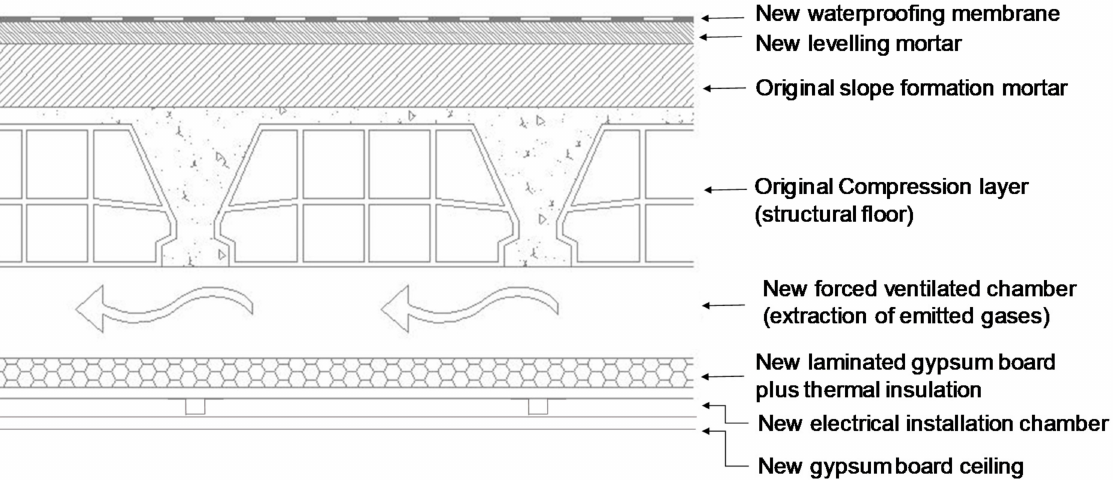
Figure 6. The constructive solution for remediation implying partial demolition of the roof.